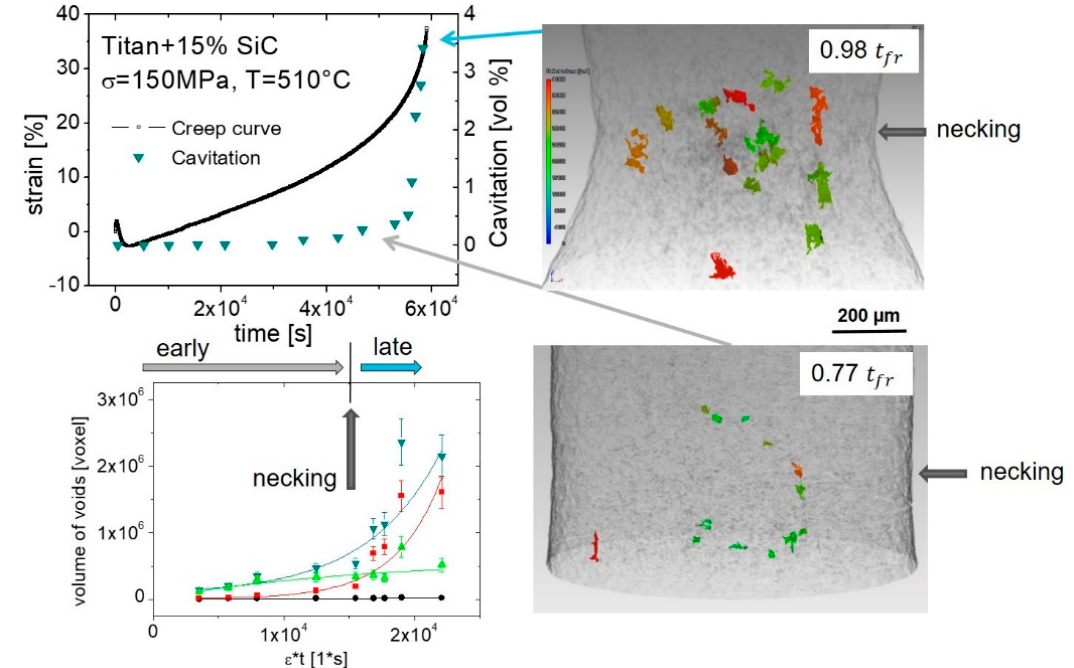
Figure 18. Ti-MMC, changeover of creep mechanisms in the transition from early to late creep stage, 𝜎 = 150 MPa, 𝑇 = 510 °C.